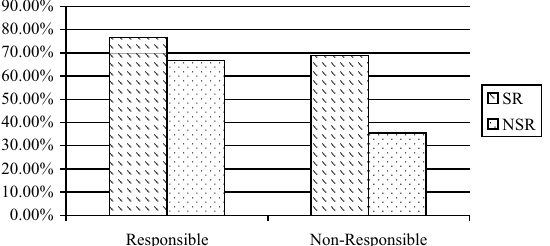
Figure 1. Percentage of decision-makers who chose to continue the project